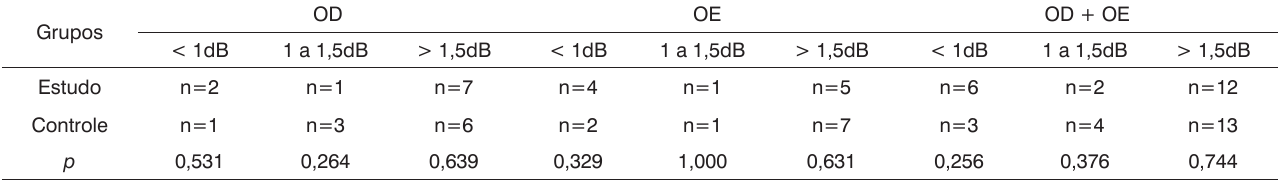
Tabela 5. Ocorrência do efeito de supressão (em dB) nos grupos estudo e controle para a Orelhas Direita (OD), Orelha Esquerda (OE) e ambas as orelhas